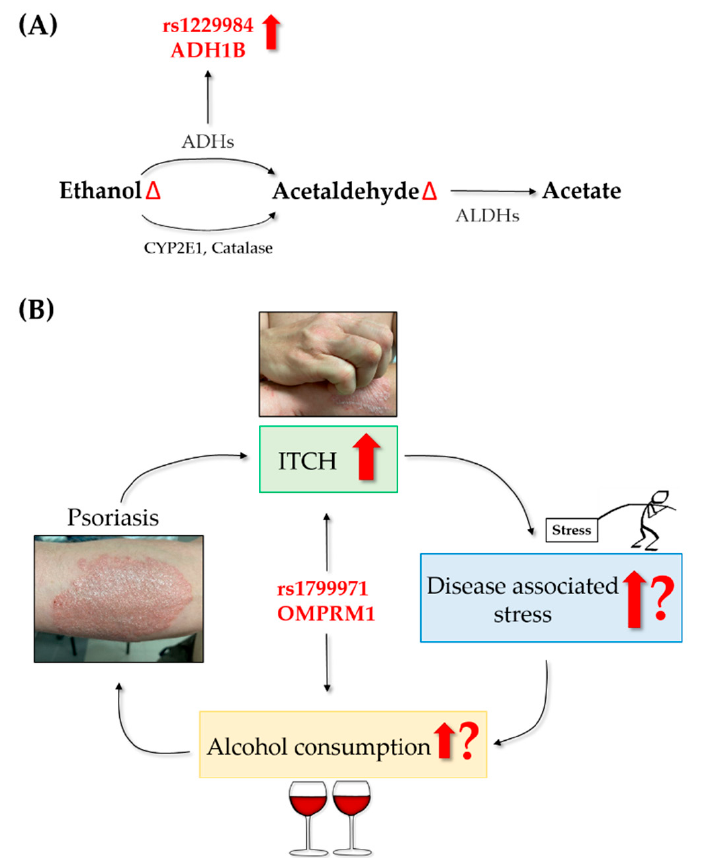
Figure 2. ( A ) Genetic variant rs1229984 (ADH1B gene), showing a significantly higher prevalence in our Hungarian psoriasis group ( n = 776) compared to the Hungarian general population ( n = 2967, leads to increased catalytic activity of the ADH enzyme that may alter the levels of ethanol and acetaldehyde. ( B ) Possible involvement of genetic variant rs1799971 (OPRM1 gene), found to increase the risk of familial psoriasis by twofold compared to sporadic cases in our Hungarian psoriasis group, in the psoriasis–itch–stress–alcohol consumption